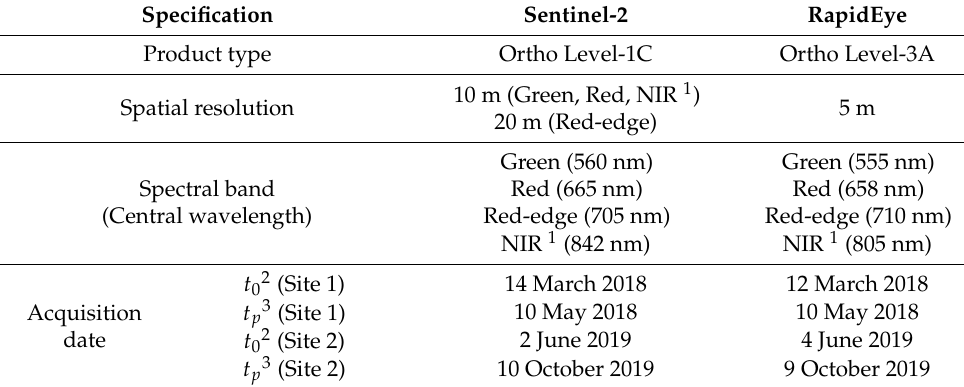
Table 1. Summary of Sentinel-2 and RapidEye images used for the